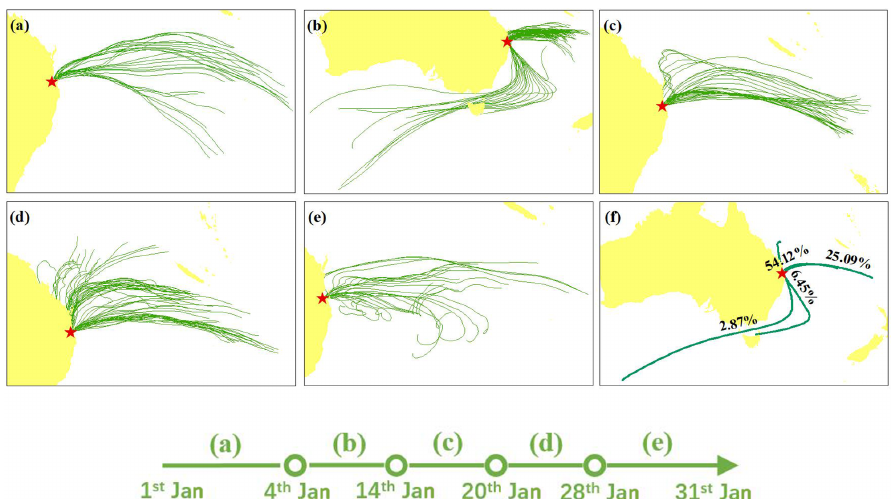
Figure 15. The site’s wind backward trajectories at 500m during January 2020. The wind backward trajectories during the first no-SLB period from 1 to 3 January (a) , the wind backward trajectories during the second no-SLB period from 5 to 13 January (b) , the wind backward trajectories during the third no-SLB period from 15 to 19 January (c) , the wind backward trajectories during the fourth no-SLB period from 21 to 27 January (d) , the wind backward trajectories during the fifth no-SLB period from 29 to 31 January (e) and the contribution of the four main wind clusters based on the wind backward trajectories during the whole month of January 2020 (f) .